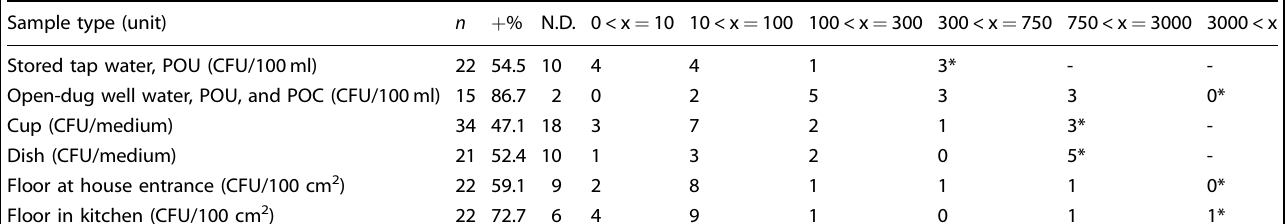
Table 3. E. coli concentration of samples in kitchens of households using pit latrines. Sample type (unit)